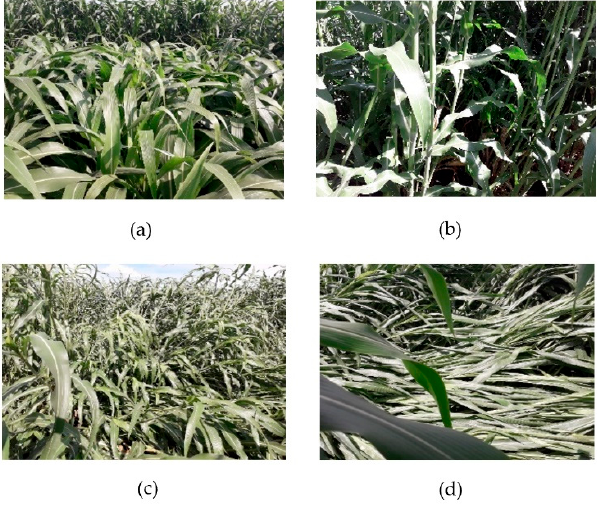
Figure 1. Example plots with different degrees of lodging severity during ground surveying. ( a ) non-lodged, ( b ) lodging severity 1 (mild), ( c ) lodging severity 2 (moderate), ( d ) lodging severity 3